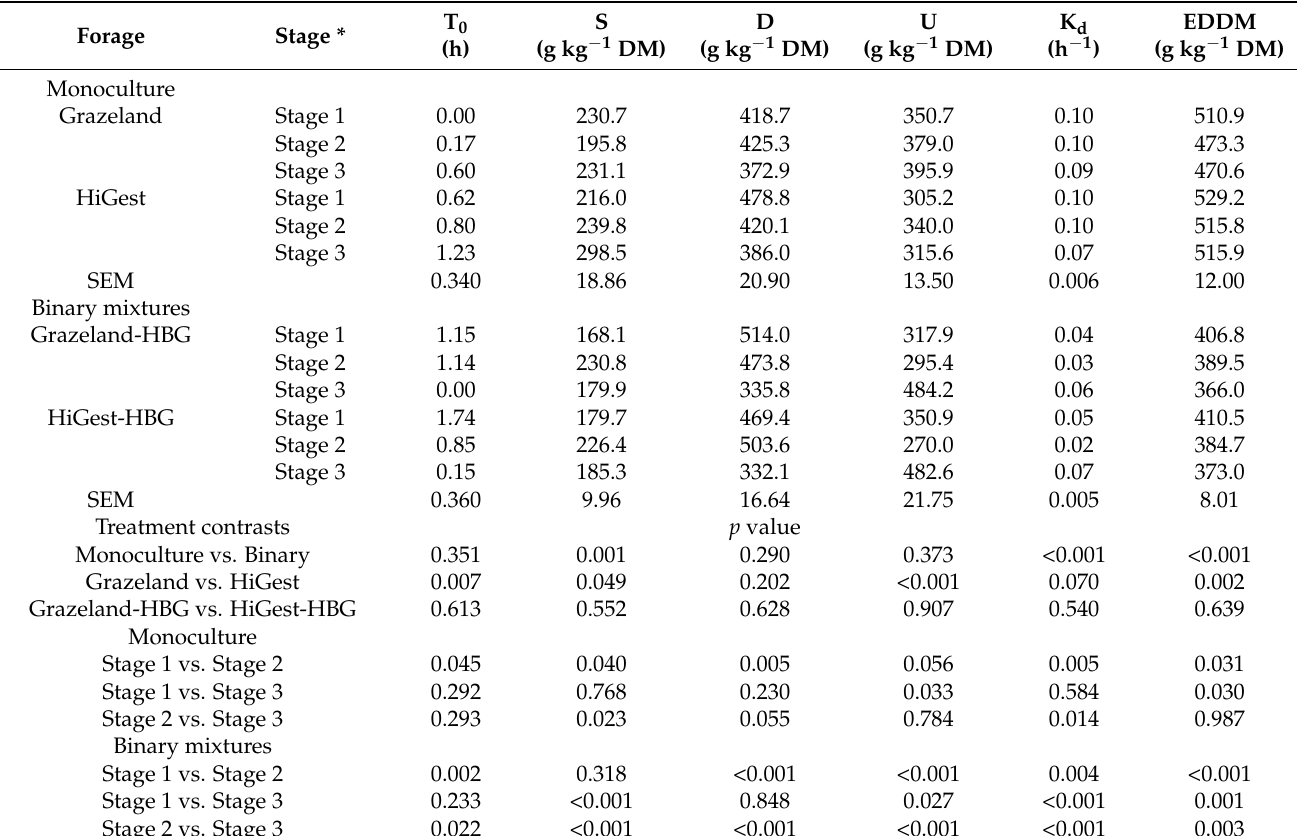
Table 3. Effects of cultivar, maturity, and their interaction on in situ rumen degradation kinetics of DM of alfalfa cultivars in monoculture and in binary mixtures with AC Success hybrid bromegrass (HBG) in Lanigan, Saskatchewan